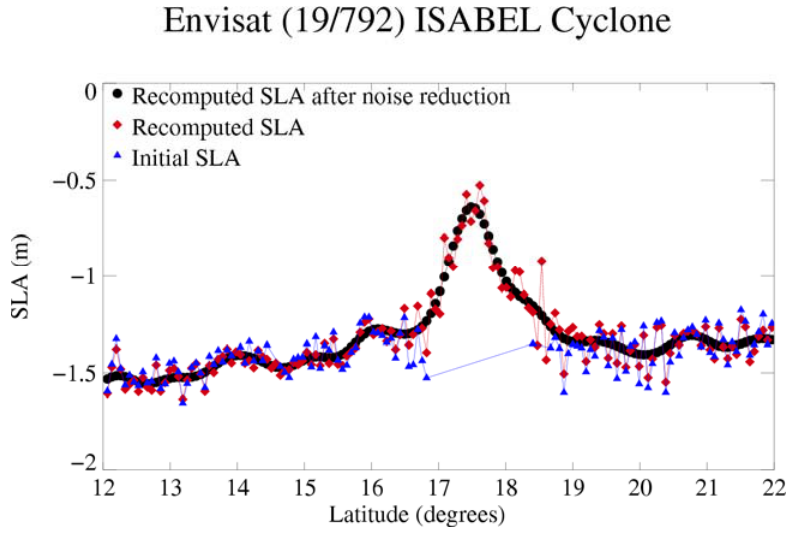
Figure 9. Comparison of initial SLA (blue), recomputed SLA with wet tropospheric and SSB corrections (red) and recomputed SLA with the noise reduction applied (black) in m for Envisat during Tropical Cyclone Isabel.